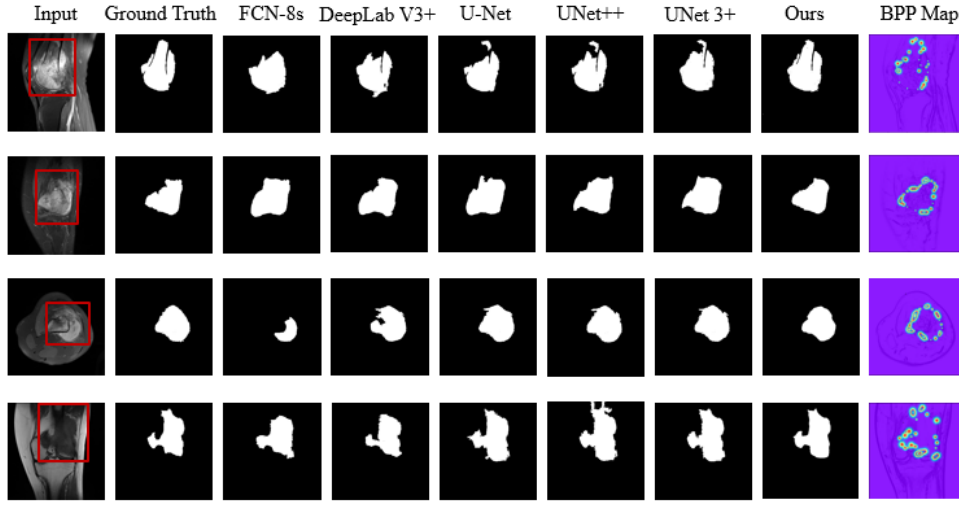
Figure 7. Segmentation results of different classical methods for typical osteosarcoma MRI images. Classical ResNet is used as the backbone in the process of extracting feature